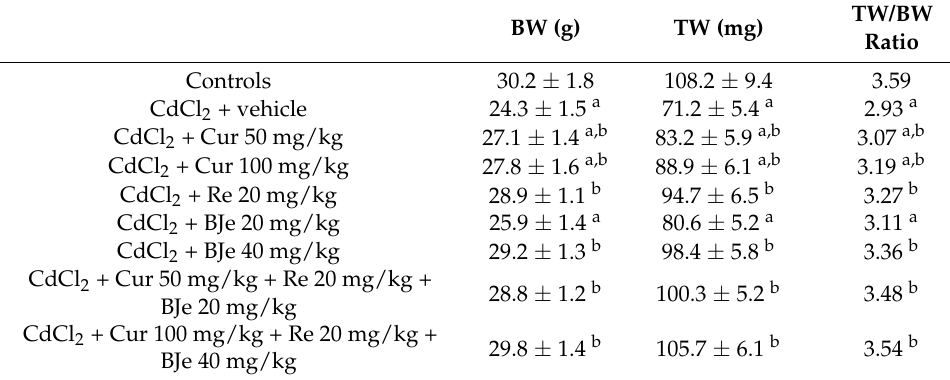
Table 1. Cur, Re, BJe, and their combinations improved BW, TW, and TW/BW in mice exposed to CdCl 2 . All values are expressed as mean ± SEM; n = 7 animals for each group.